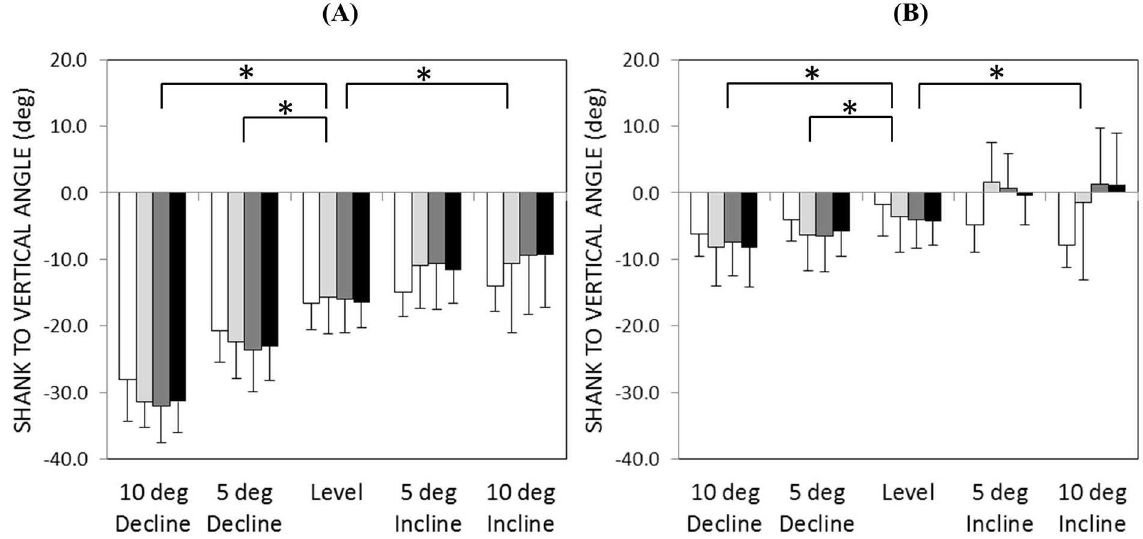
Fig 7. (A) Minimum and (B) maximum SVA (+ 1 standard deviation) during single-limb support (control = white, RIGID = light gray, MULTI = gray, HYDRA = black). Positive angles correspond to a reclinedshank posture (i.e., the posture that wouldbe expectedat initial contact). An asterisk ( * ) indicatesa statistically significantwithin-group difference (p < 0.05)betweenlevel and the sloped walkingconditionacross all prosthetic